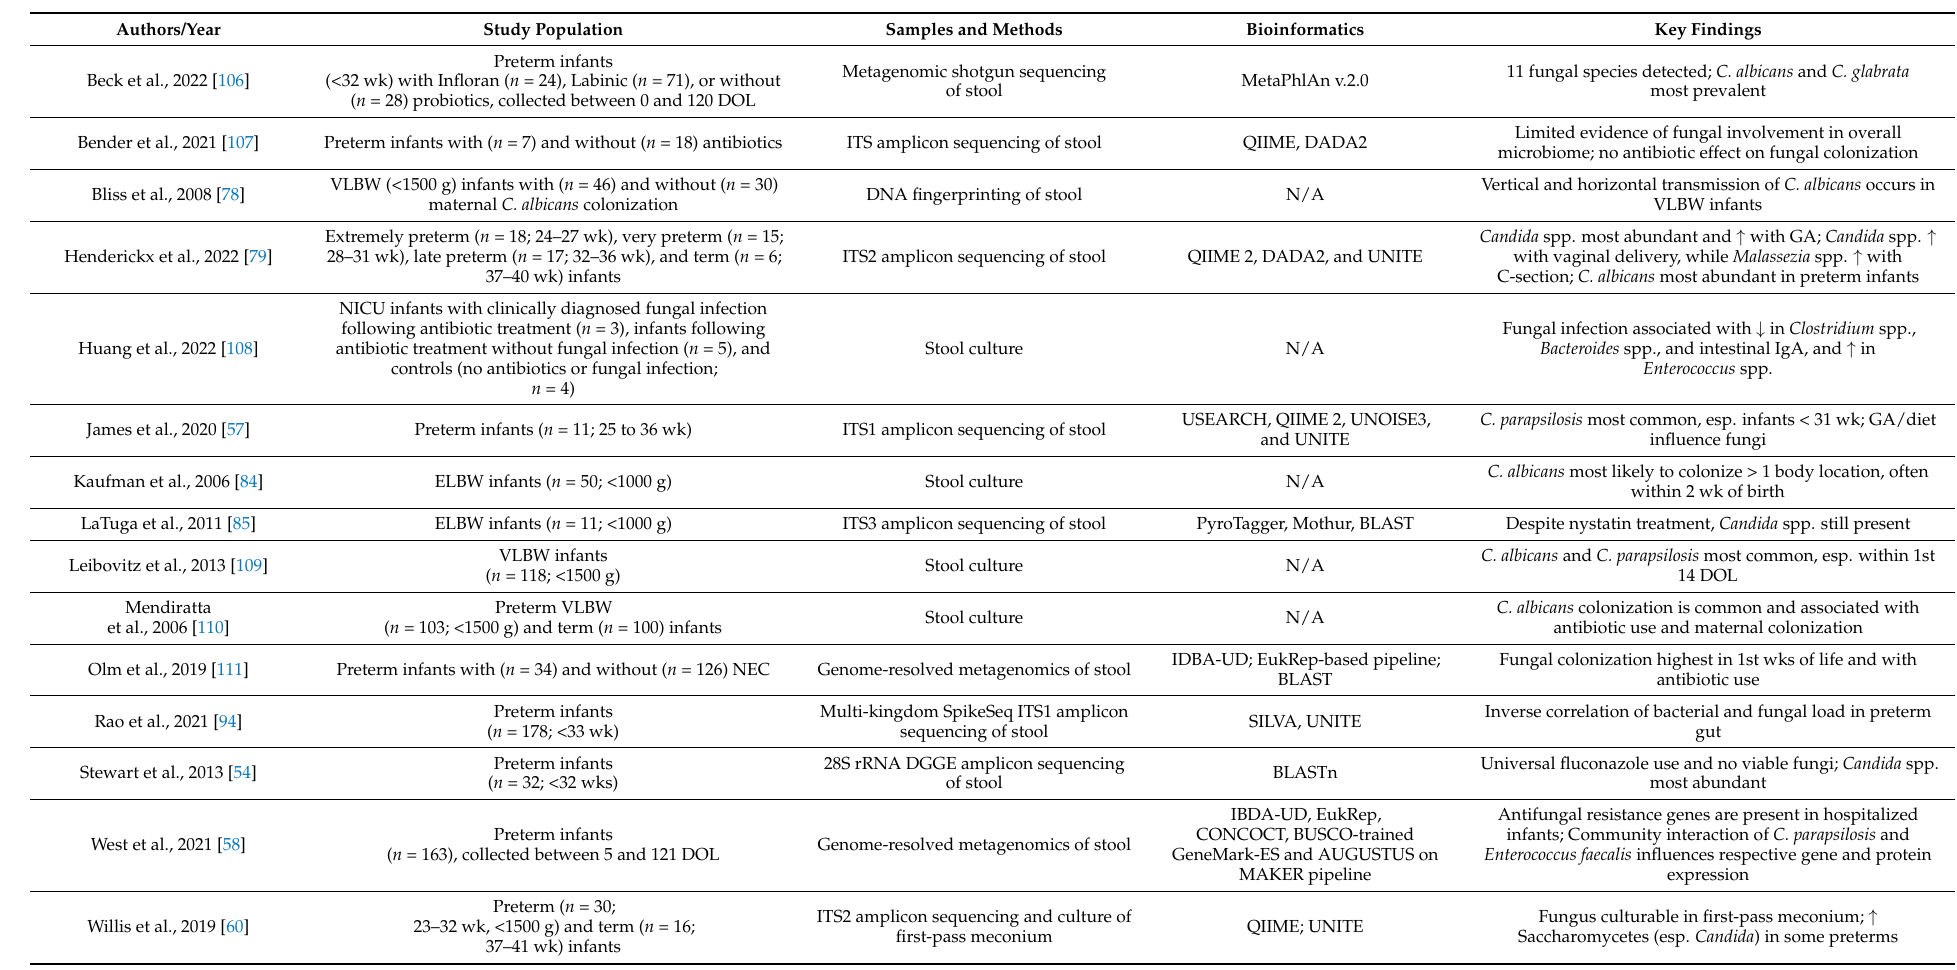
Table 1. Overview of key preterm infant gut fungal sequencing